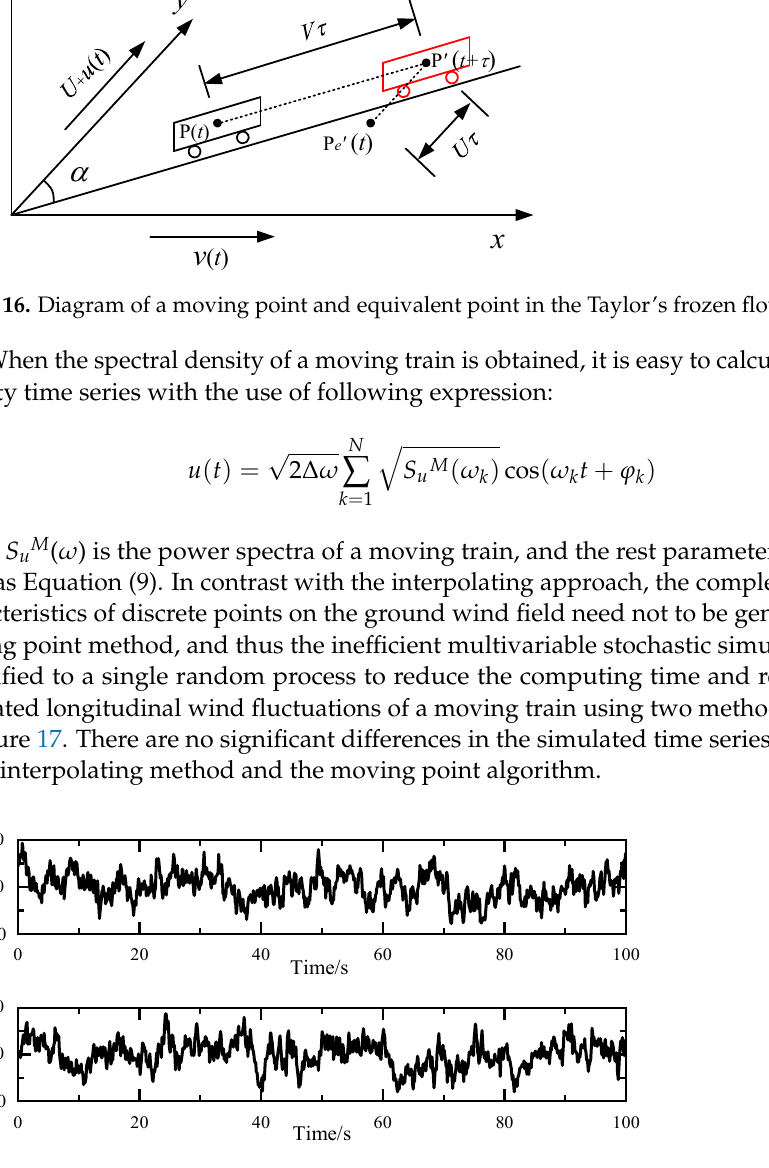
Figure 17. Simulated longitudinal wind turbulences of a moving train using different methods ( U = 20 m/s, α = 90°, V = 300 km/h, V R = 85.7 m/s, β = 13.5°): ( a ) an interpolating approach; ( b ) a moving point approach.